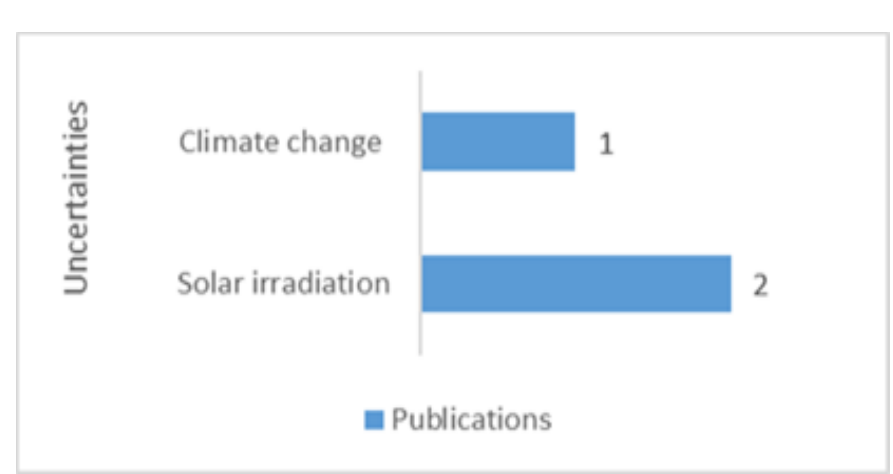
Figure 5. Environment.